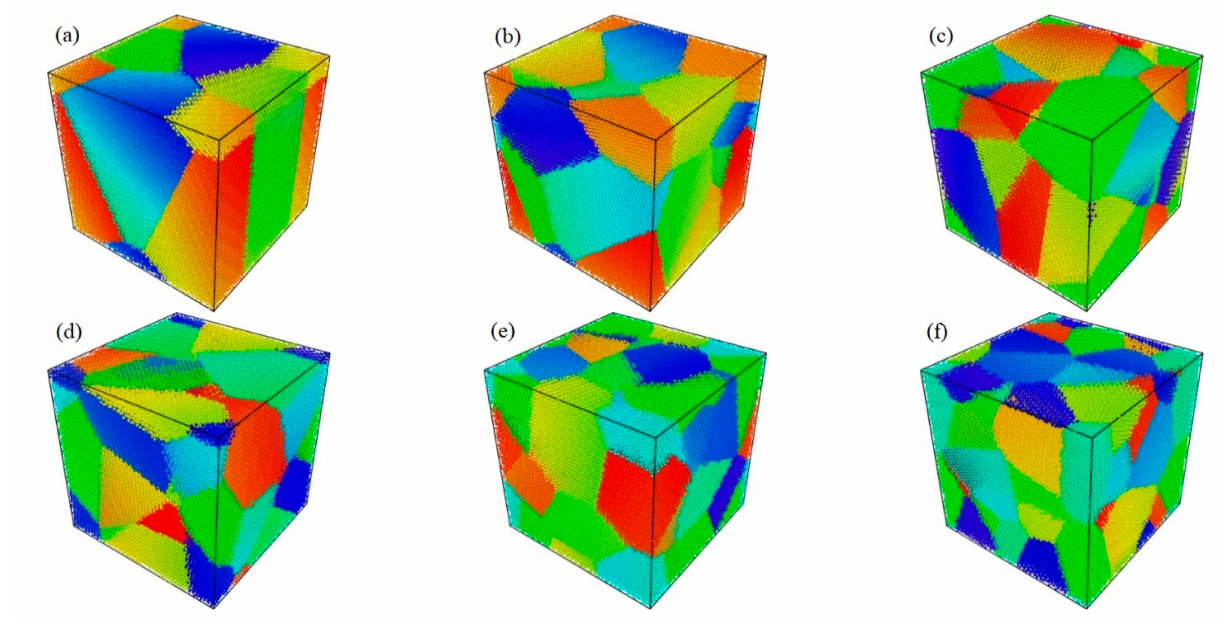
Figure 2. Polycrystalline Cu 6 Sn 5 with average grain size of ( a ) 17 nm, ( b ) 14 nm, ( c ) 12 nm, ( d ) 11 nm, ( e ) 9 nm, and ( f ) 8